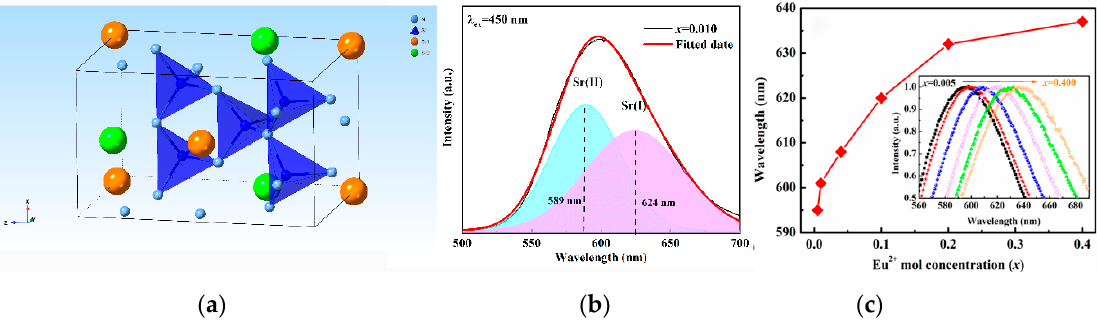
Figure 7. ( a ) Crystal structure of Sr 2 Si 5 N 8 ; ( b ) experimental emission spectrum and fitted and decomposed components of emission spectrum by Gaussian deconvolution on an energy scale of Sr 1.990 Si 5 N 8 : 0.010Eu 2+ phosphors; ( c ) the dependence of the emission peak position of Sr 2 − x Si 5 N 8 : x Eu 2+ phosphors on Eu 2+ ion concentration. Insert is the enlarged normalized emission spectra.